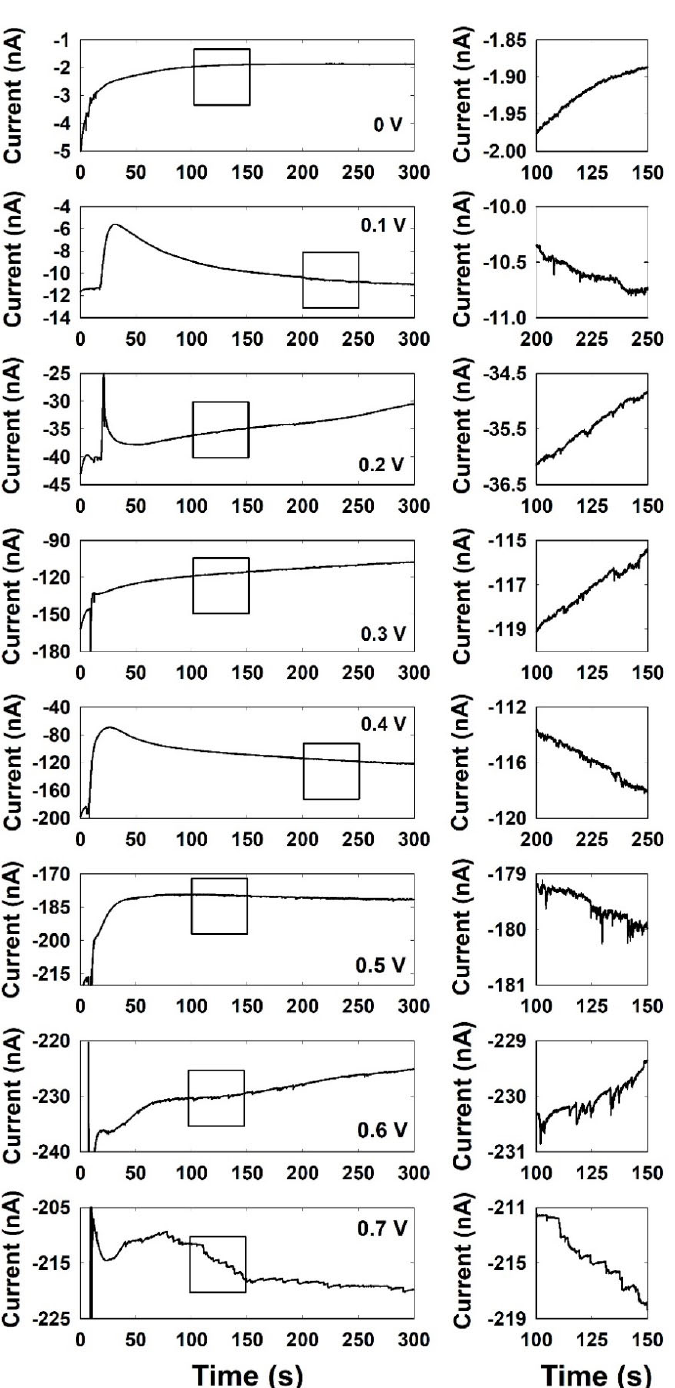
Figure 2. Chronoamperometric curves for single Ag NP collisions at the Cu UME with different applied potentials from 0 V to 0.7 V in a 0.1 M NaOH solution containing 15 mM hydrazine. Data acquisition time is 50 ms.